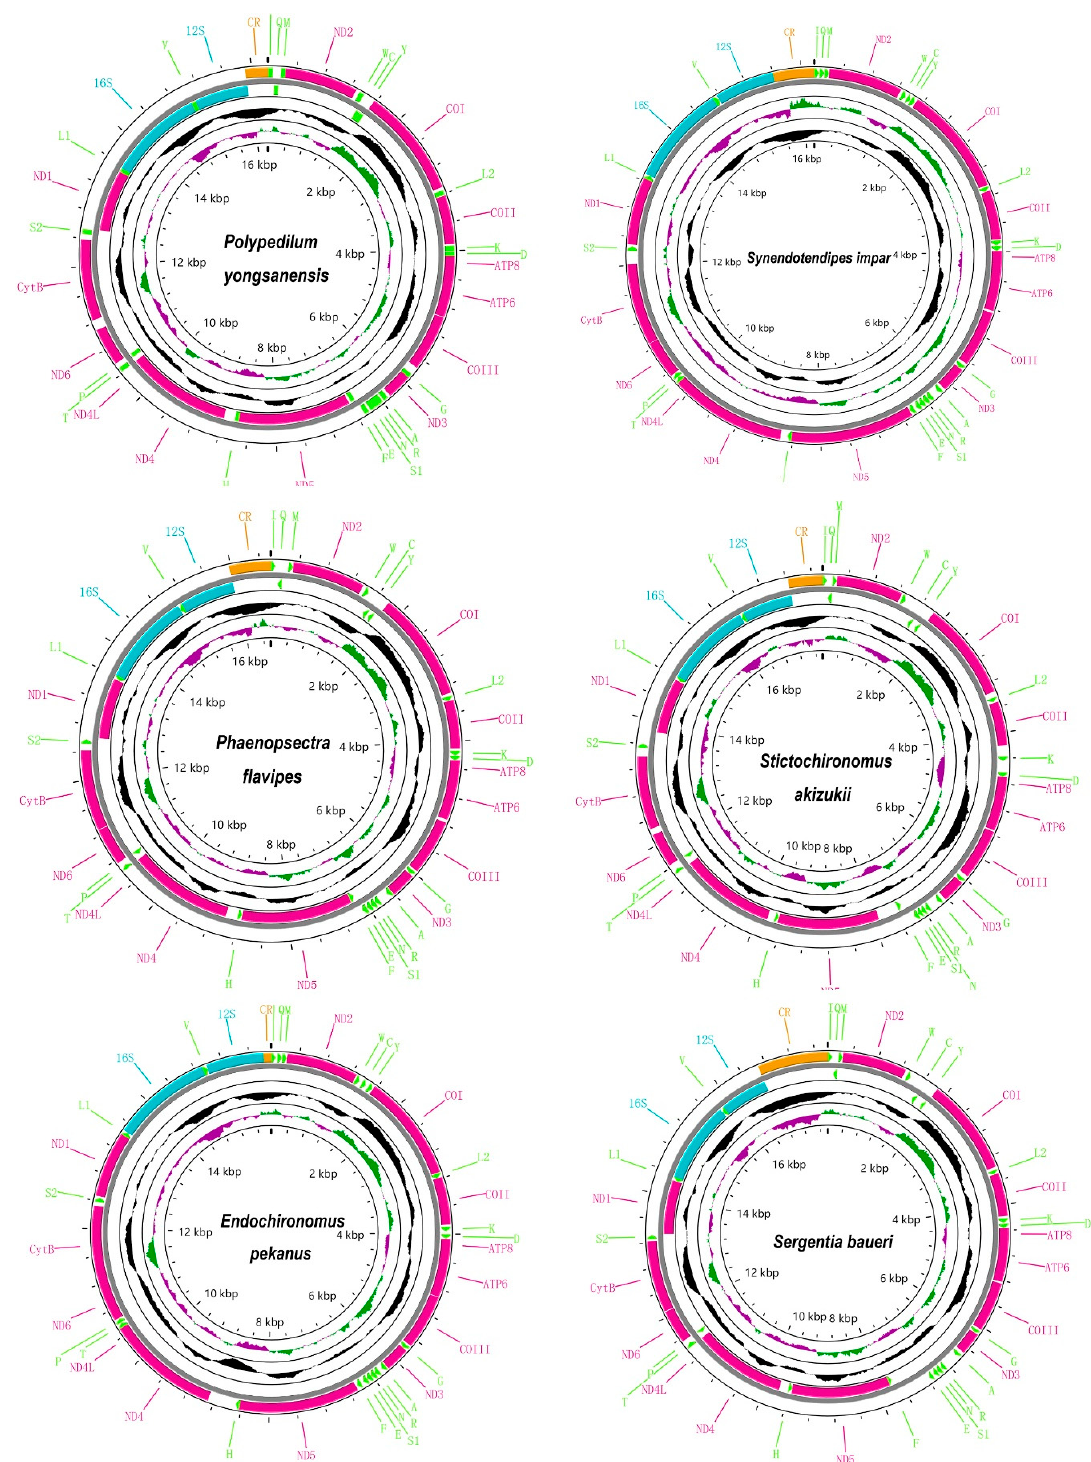
Figure 1. Mitogenome map showed the mitochondrial genome characteristics of representative species from six genera within the Polypedium generic complex. The arrow indicated the direction of gene transcription. We used normative abbreviations to represent PCGs and rRNAs, and single letter abbreviations were used to represent tRNAs. Red, green, blue, and orange represented PCGs, tRNA, rRNA, and CR, respectively. GC content of complete mitogenome showed in the second circle. GC-skew of complete mitogenome showed in the third circle. The innermost circle showed the length of complete mitogenome.